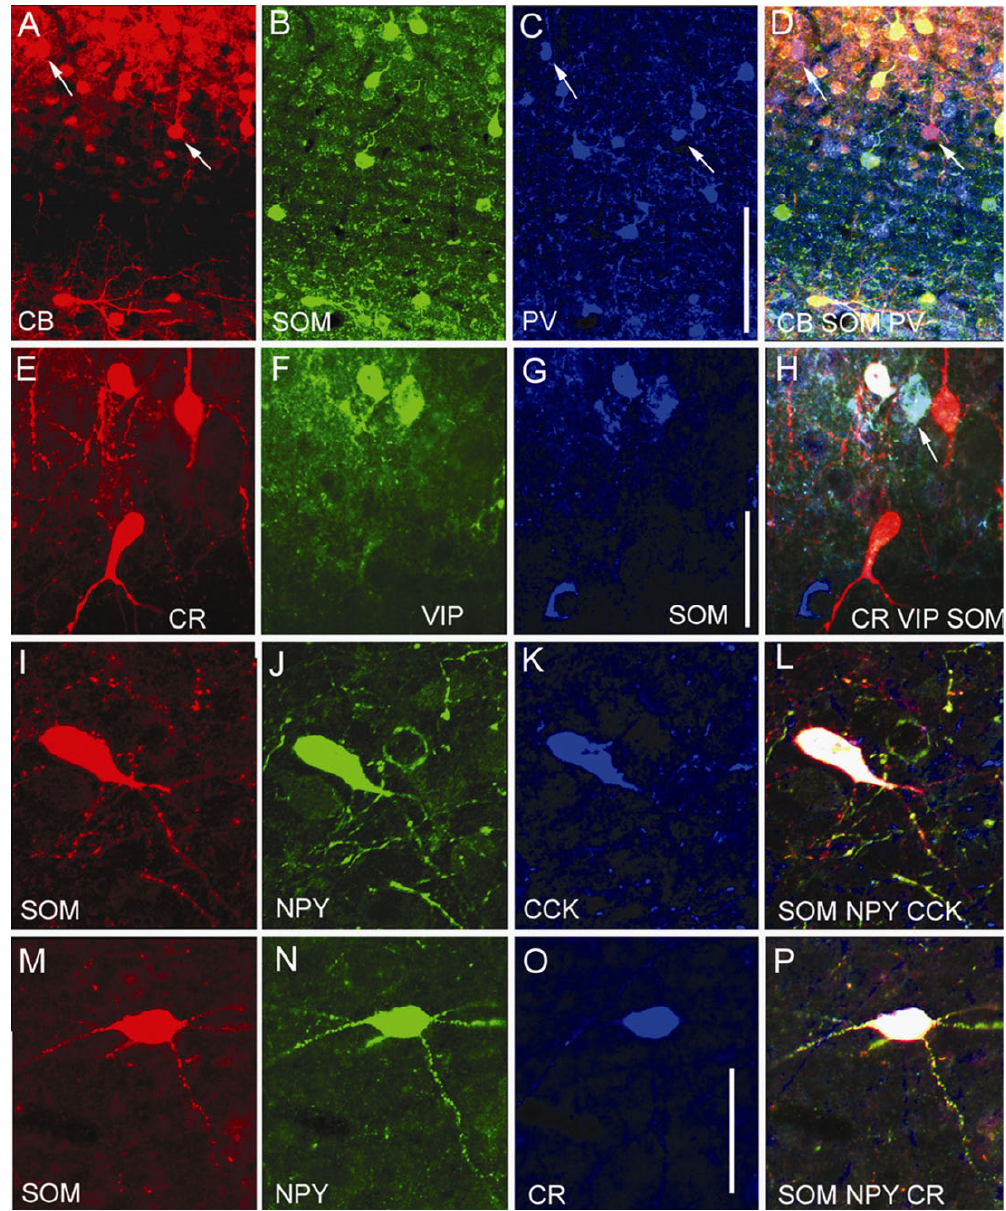
Figure 5. Triple immunolabeling with antibodies against calcium binding proteins and peptides in interneurons of coronal sections through adult mouse visual cortex. (A–D) Expression of calbindin (CB), SOM and PV. CB is colocalized in subset of PV (pink cells in D indicated by arrows in C and D ) and SOM neurons (yellow cells in D ). (E–H) Expression of CR, VIP and SOM. Colocalization of CR + VIP + SOM (white cell in H ) and VIP + SOM (light blue cell in H ) in subset of interneurons. (I–L) Expression of SOM, NPY and CCK. Colocalization of SOM + NPY + CCK (L). (M–P) Expression of SOM, NPY and CR. Colocalization of SOM + NPY + CR (P) . Scales: 100 μ m (A–D) , 25 μ m (E–L) , 20 μ m (M–P)